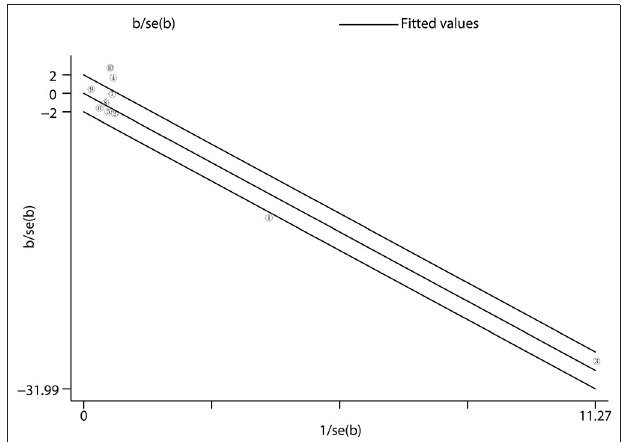
FIGURE 5 | Heterogeneity analysis. Heterogeneity was evaluated by Galbraith radial plot. The office measurement studies were included for the analysis. ‹ = Mahfound et al. (16) … (cid:181) = Lurz et al. (28).